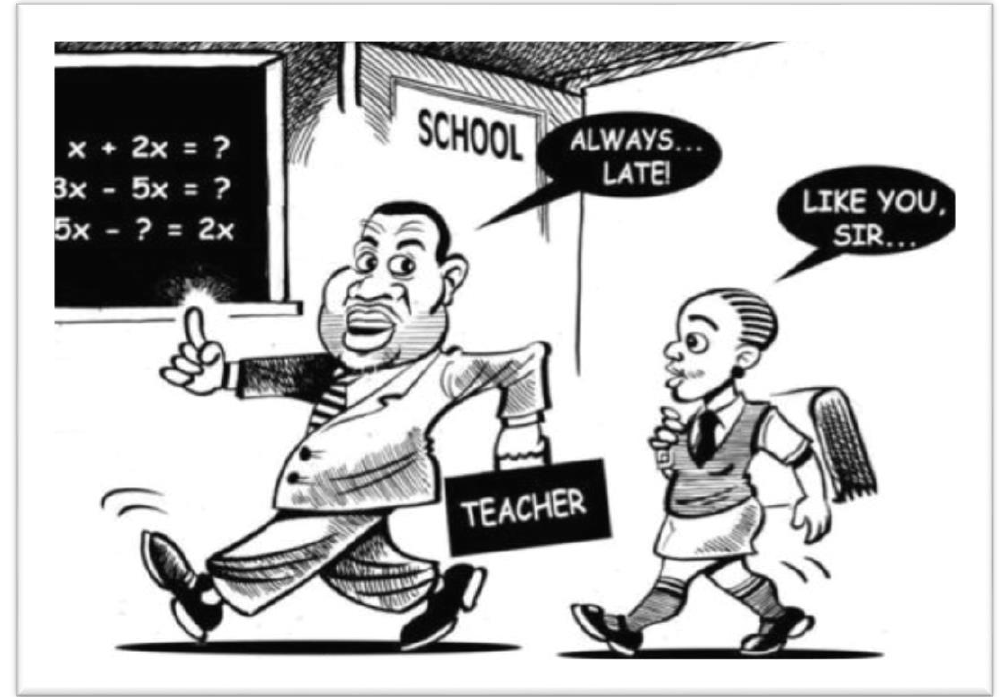
Siwela : Feb 17 2012: The Citizen